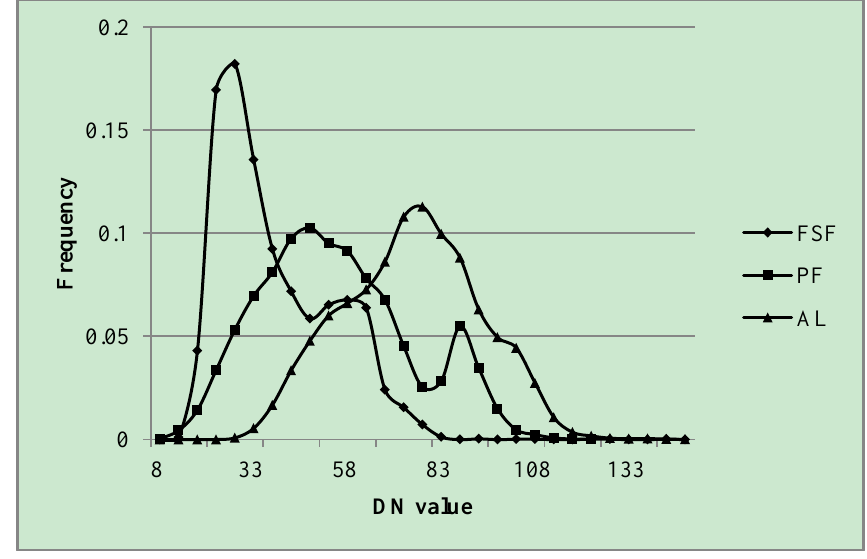
Figure 10. Frequency distribution of DN value for FSF, PF and AL in Landsat 5 TM NIR band.